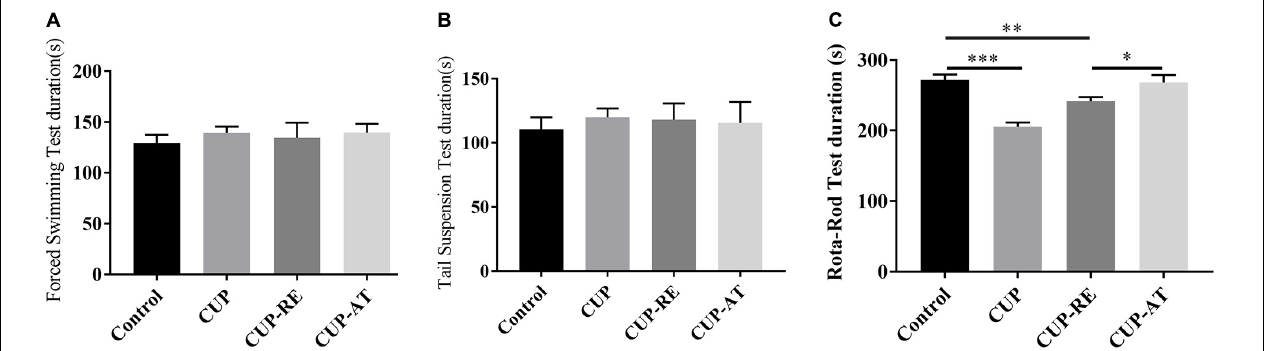
FIGURE 8 | Dietary supplementation of Acer truncatum oil improved the recovery of CUP-induced physical coordination in mice. (A) The immobility time of the last 4 min of the 5 min of FST. n = 8–15/group. (B) The immobility time of the last 4 min of the 5 min of TST. n = 6–10/group. (C) Dietary supplementation of Acer truncatum oil significantly improved the recovery of CUP-induced Rota-rod changes in mice. n = 8–12/group. Data were expressed as means ± SEM. Differences between groups were expressed as ∗ p < 0.05, ∗∗ p < 0.01, ∗∗∗ p <